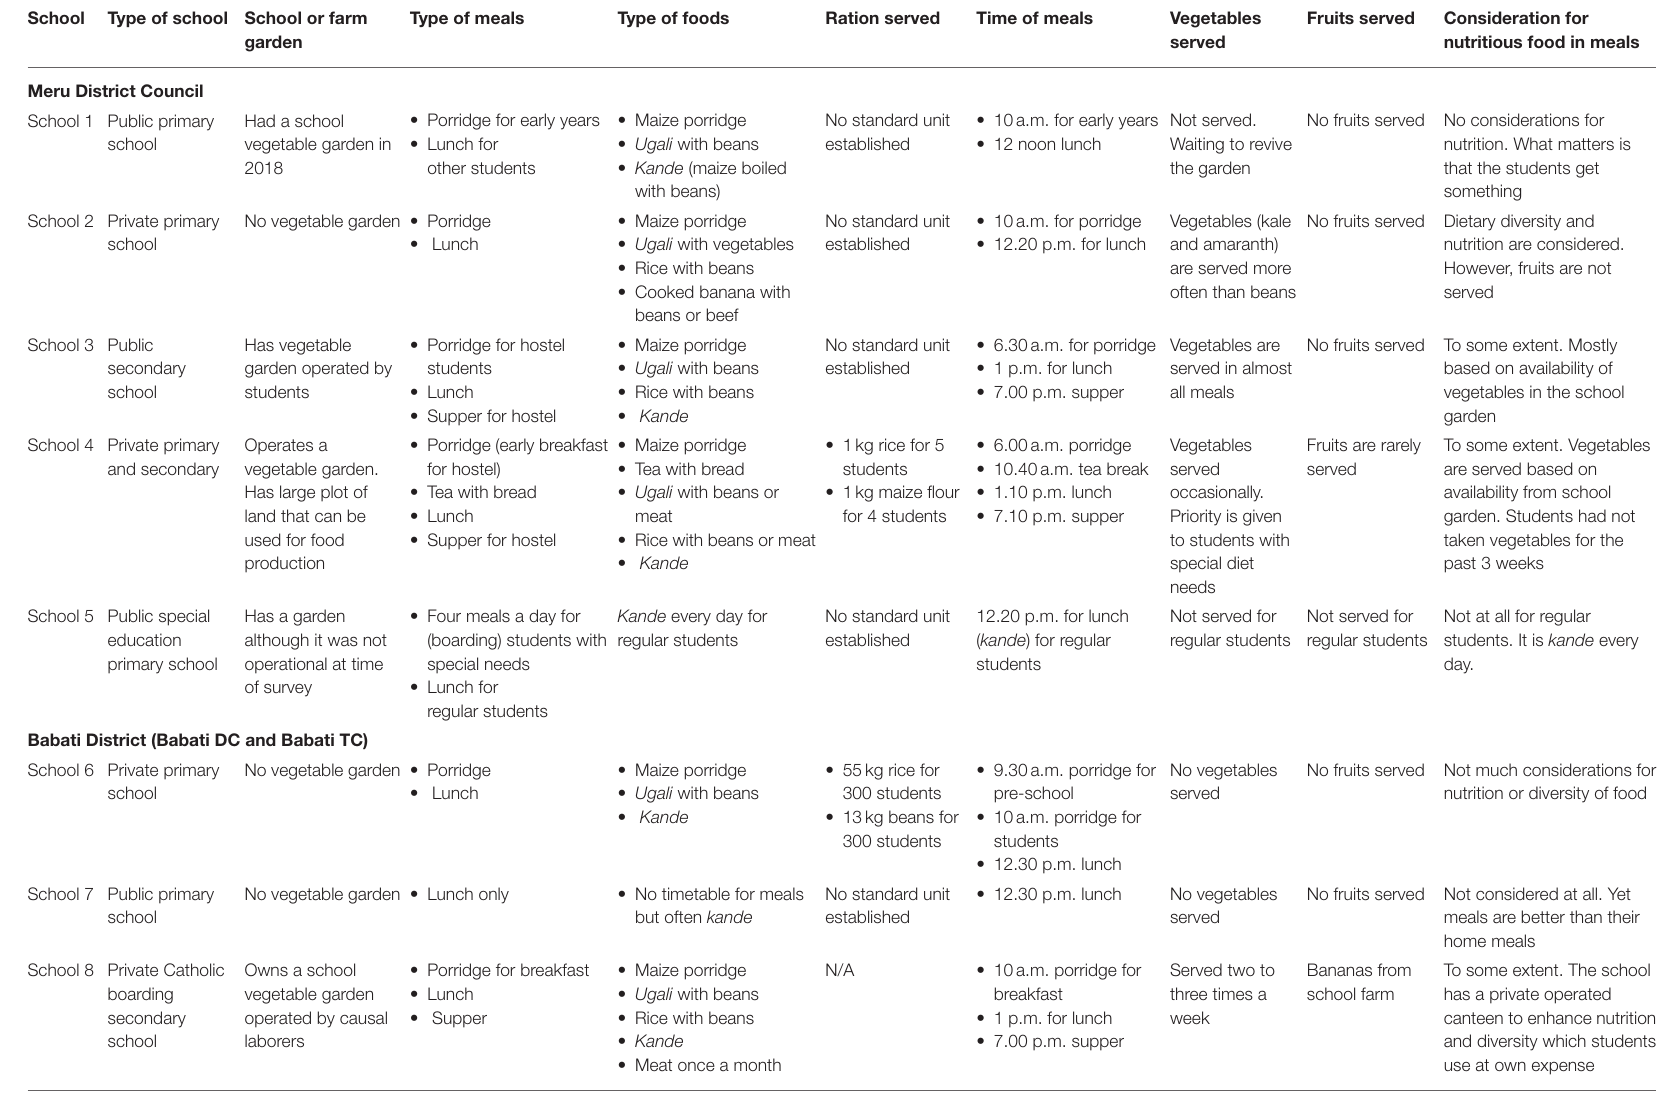
TABLE 5 | Type of meals and dietary diversity in school feeding